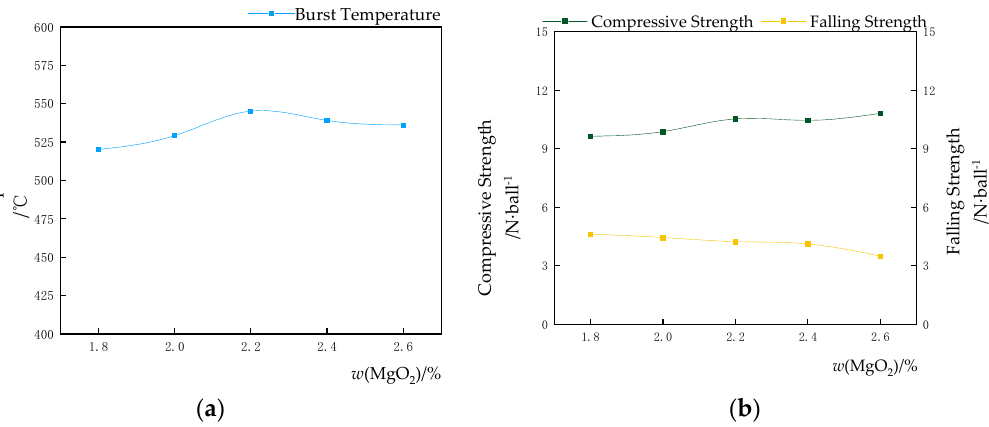
Figure 3. Effect of MgO content on green pellet performance. ( a ) Burst temperature trend chart, ( b ) Compressive strength and falling strength trend chart.